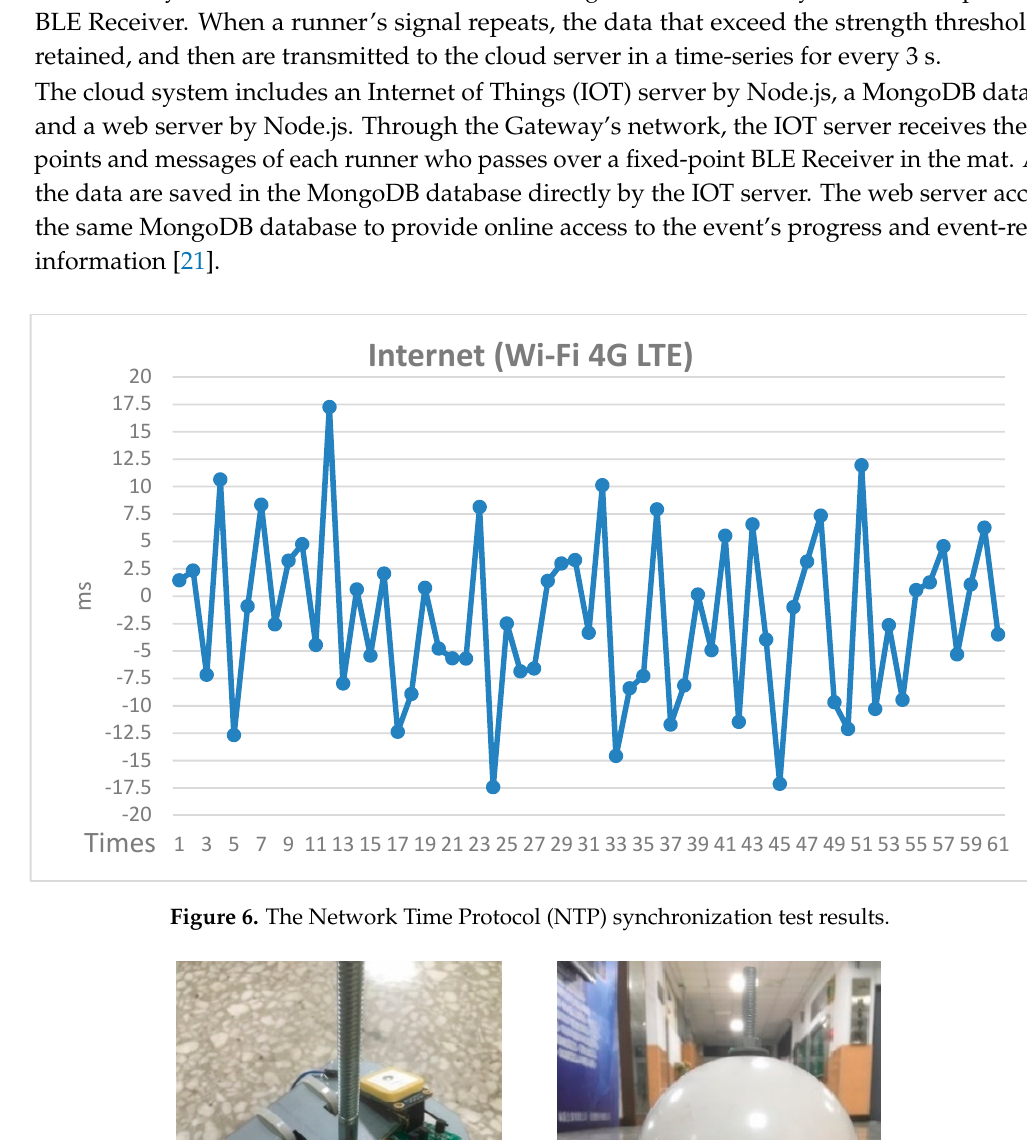
Figure 6. The Network Time Protocol (NTP) synchronization test results.